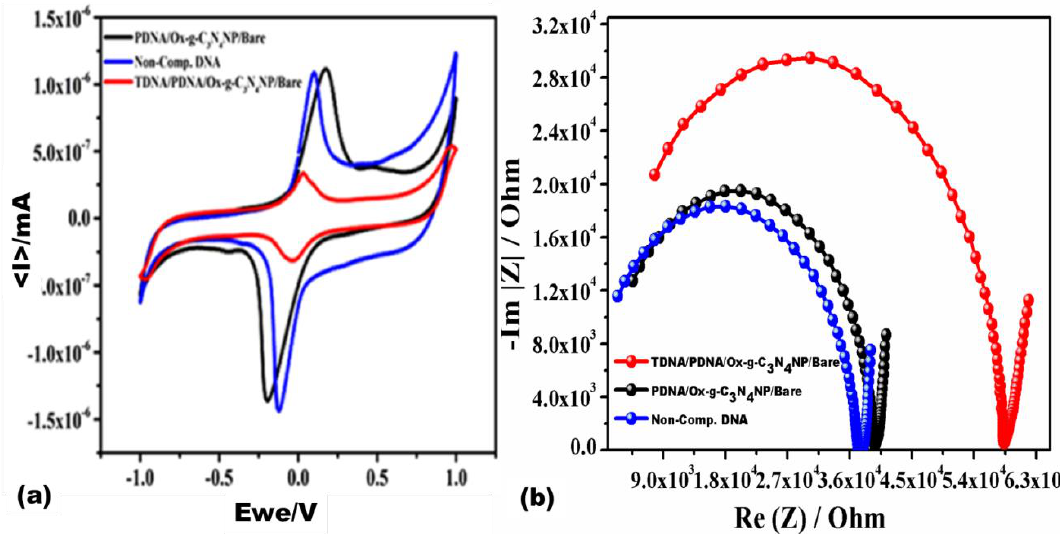
Figure 4. ( a ) CV of ( i ) PDNA / Ox-g-C 3 N 4 / ePAD ( ii ) PDNA / Ox-g-C 3 N 4 / ePAD + non complementary DNA (iii) PDNA / Ox-g-C 3 N 4 / ePAD + complementary DNA ( b ) Nyquist plots.